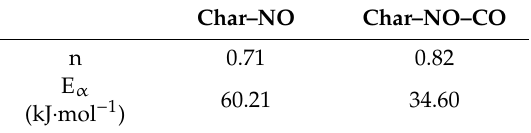
Table 5. Reaction orders and activation energies for NO reduction of rice husk char.